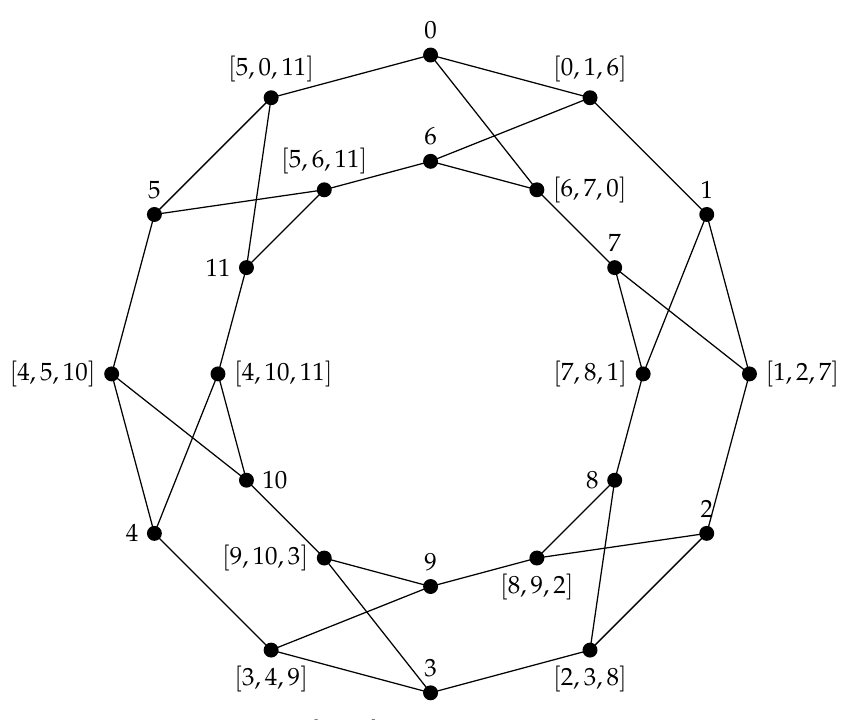
Figure 2. A half-step graph G 24 [ 0,1,6 ]